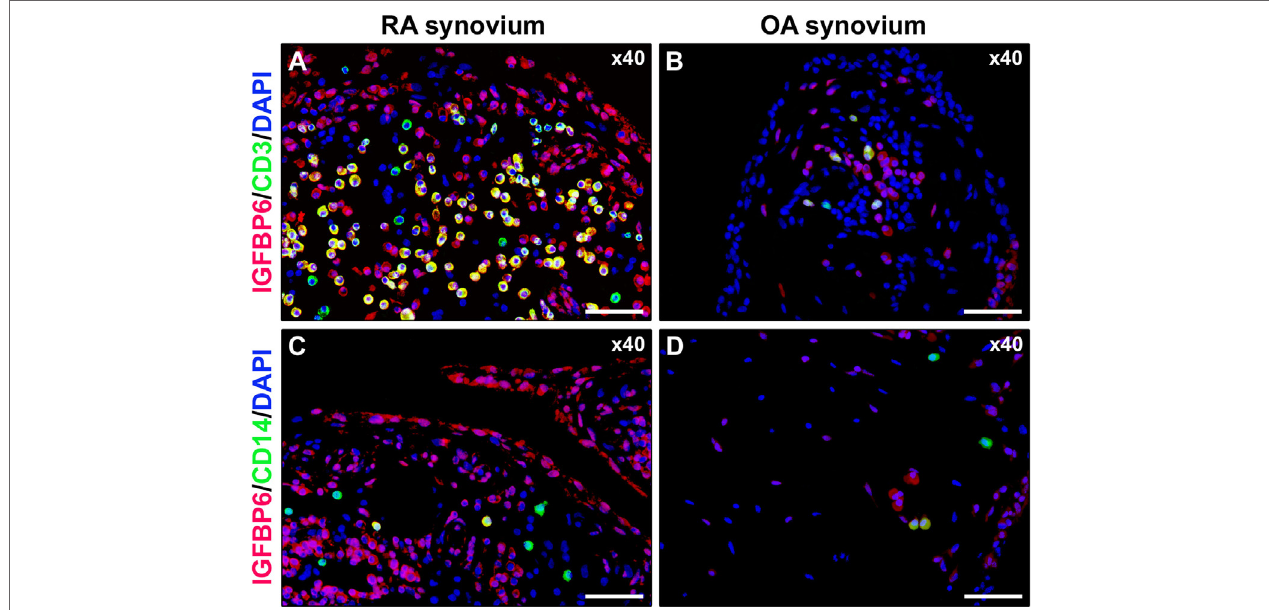
FigUre 5 | insulin-like growth factor binding protein 6 (igFBP6) expression in synovial infiltrating immune cells . Representative microphotographs of synovial sections from rheumatoid arthritis (RA) patients (a,c) and osteoarthritis (OA) controls (B,D) double immunostained for IGFBP6 (red) and the T-cell marker CD3 (green) (a,B) or the monocyte marker CD14 (green) (c,D) . Nuclei are counterstained with 4 ′ ,6-diamidino-2-phenylindole (DAPI; blue). Numerous CD3 + T cells displaying strong immunopositivity for IGFBP6 (yellow cytoplasmic staining) are present in RA synovial membrane (a) . Only a few CD14 + monocytes coexpressing IGFBP6 can be observed in RA synovium (c) . Original magnification: × 40 (a–D) . Scale bar: 50 µm (a–D)